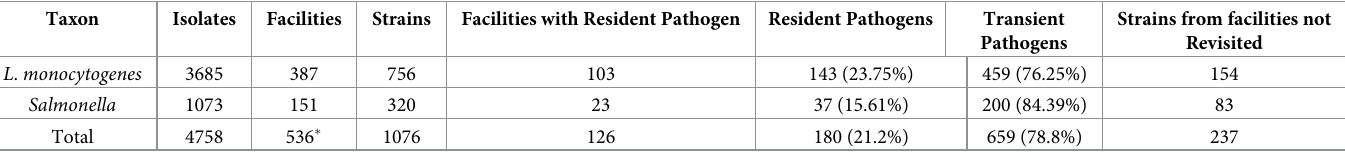
Table 1. The number of isolates (collected between August 2000 and March 2020) analyzed, and the number of different strains and resident pathogens detected. Taxon